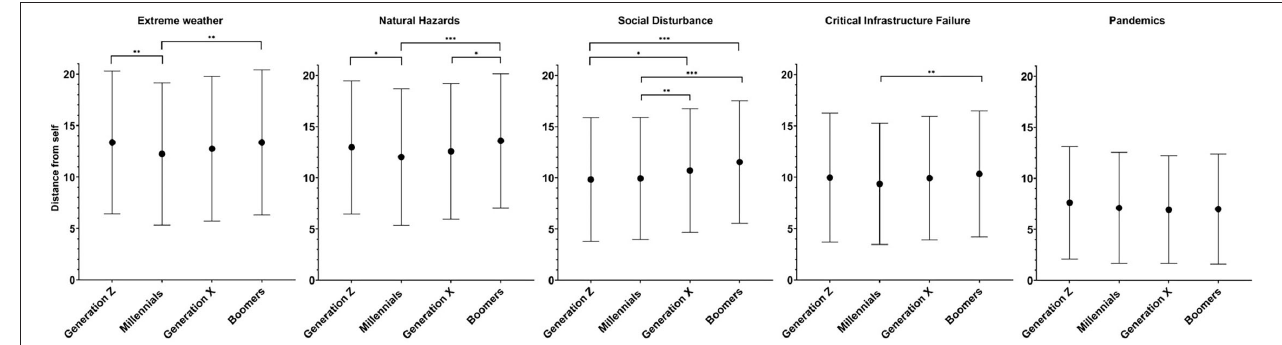
FIGURE 2 | Results of the iPRISM tool assessing risk awareness through distances assigned by participants between themselves (yellow “SELF” disk) and specific risk objects across age groups (“Generation Z”: 18–24 years of age, “Millennials”: 25–40, “Generation X”: 41–56, and “Boomers” and earlier generations: 57 and above). * p < 0.05, ** p < 0.01, *** p <